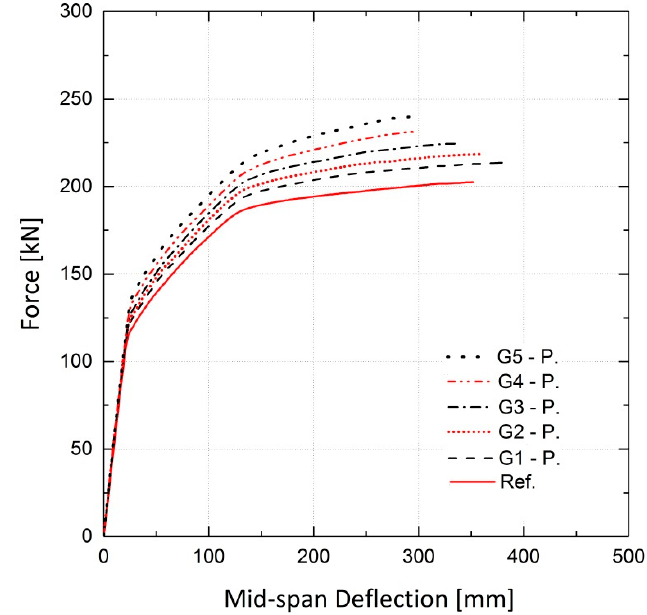
Figure 30. E ff ect of activated Fe-SMA bars on load–deflection behavior of girders compared to the reference.